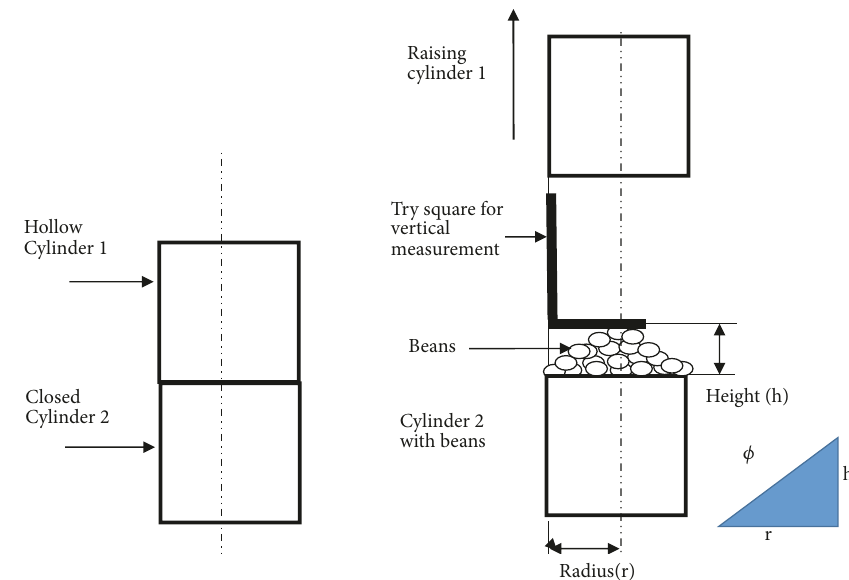
Figure 4: Experimental setup for repose angle measurements.